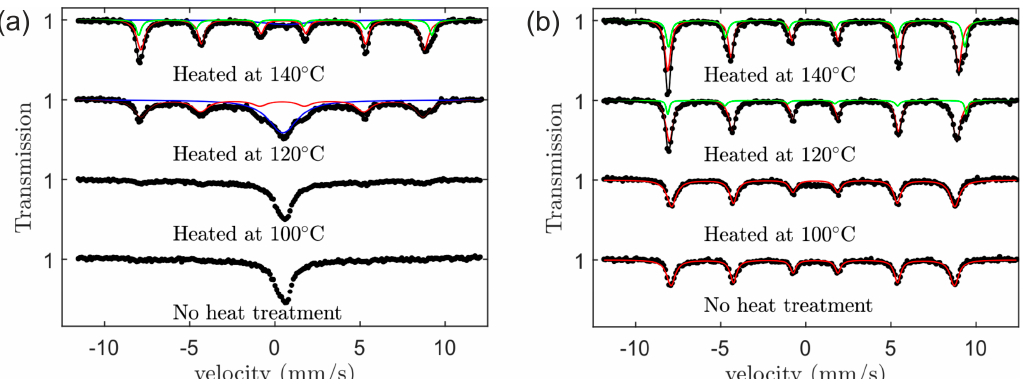
Figure 11. Mössbauer spectra of the as-prepared sample (without NaCl) heated at the indicated temperatures. ( a ) Measurement at 80 K; ( b ) Measurement at 20 K. Fit to the superparamagnetic doublet is plotted in blue, and sextets for hematite with and without Morin transition are plotted in green and red, respectively.